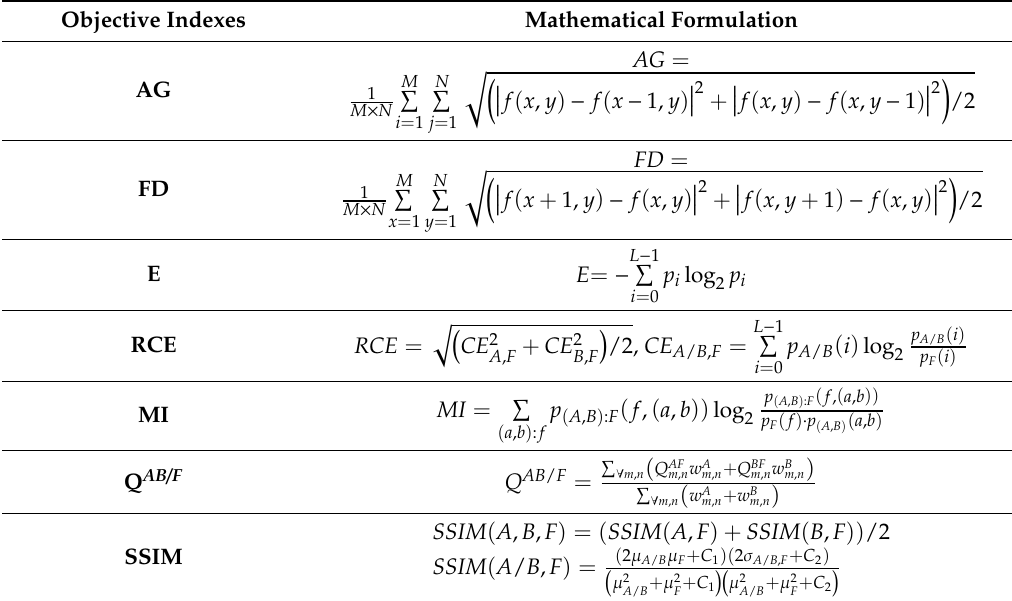
Table 1. Objective index and mathematical description of the fused image. AG, average gradient; RCE, root mean square cross entropy; FD, figure definition; E, information entropy; MI, mutual information; Q AB / F , edge-based similarity measure; SSIM, structural similarity